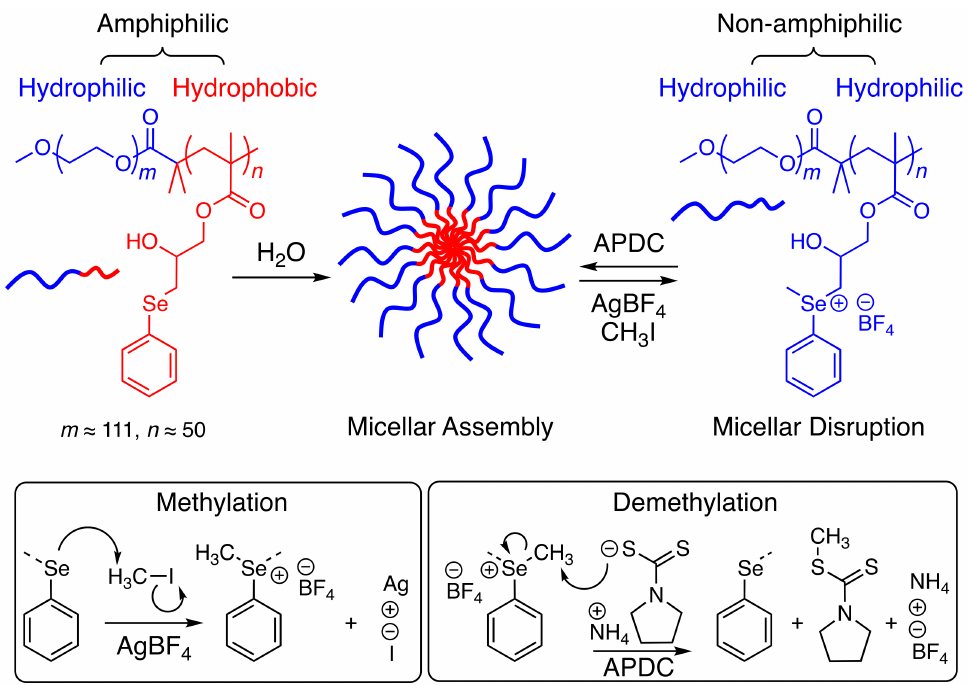
Figure 1. The concept of controlling chemical nature of the polymer chain and, thus, its assem- bly/disassembly behavior in water through alkylation/dealkylation process (APDC—ammonium